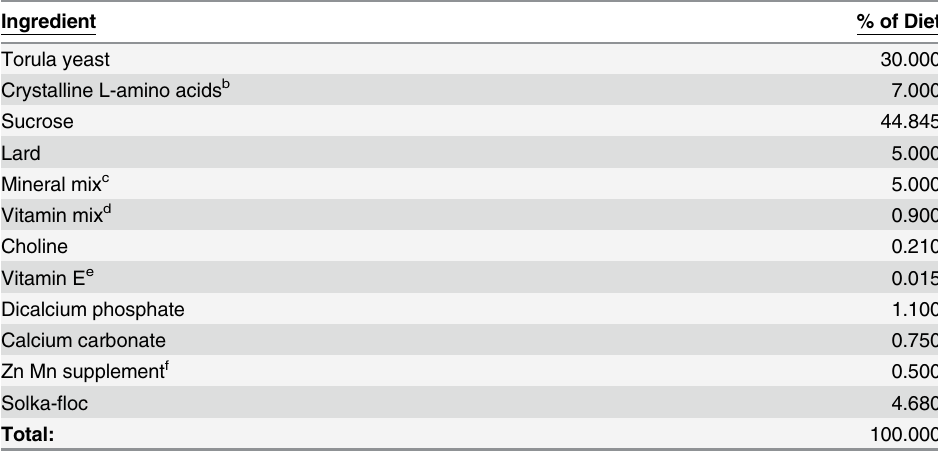
Table 1. Basal torula yeast-based poult diet a